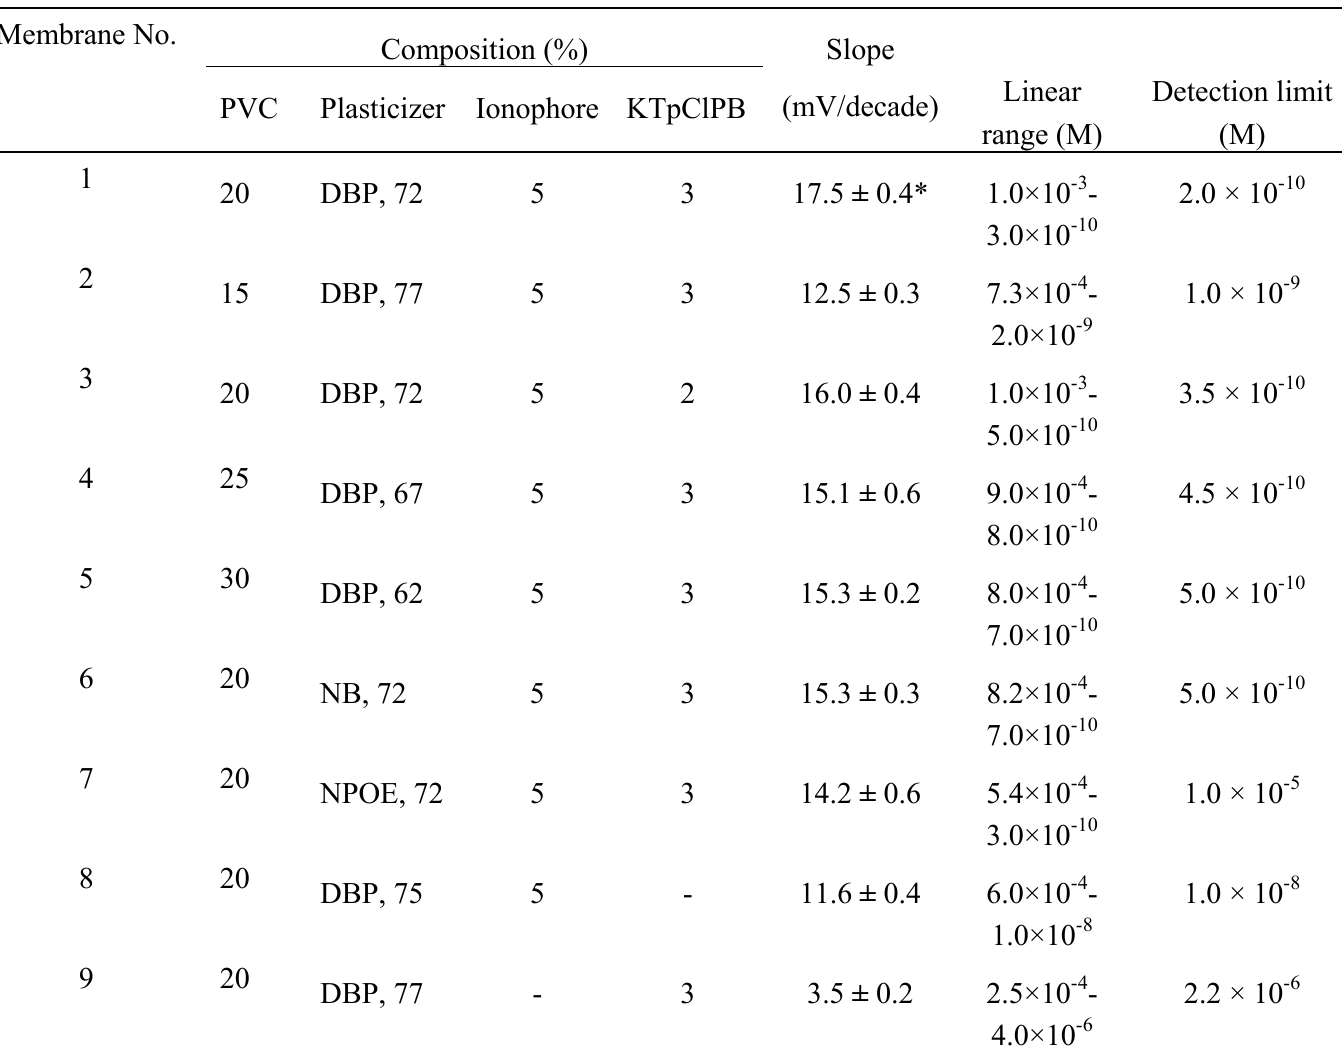
Table 2. Optimization of membrane ingredients Membrane